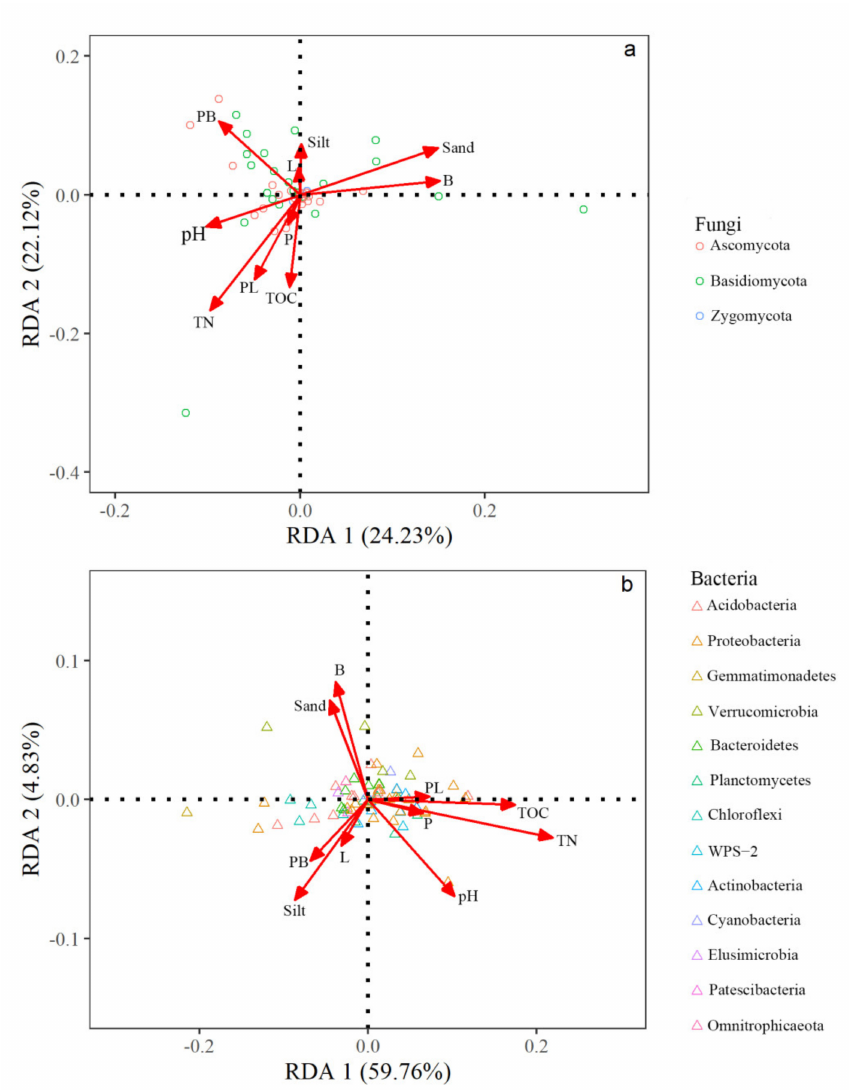
Figure 4. Redundancy analysis of fungi (ITS) ( a ) and bacteria 16S rRNA ( b ). Data were calculated by mean relative abundance > 0.1%; families and color according to